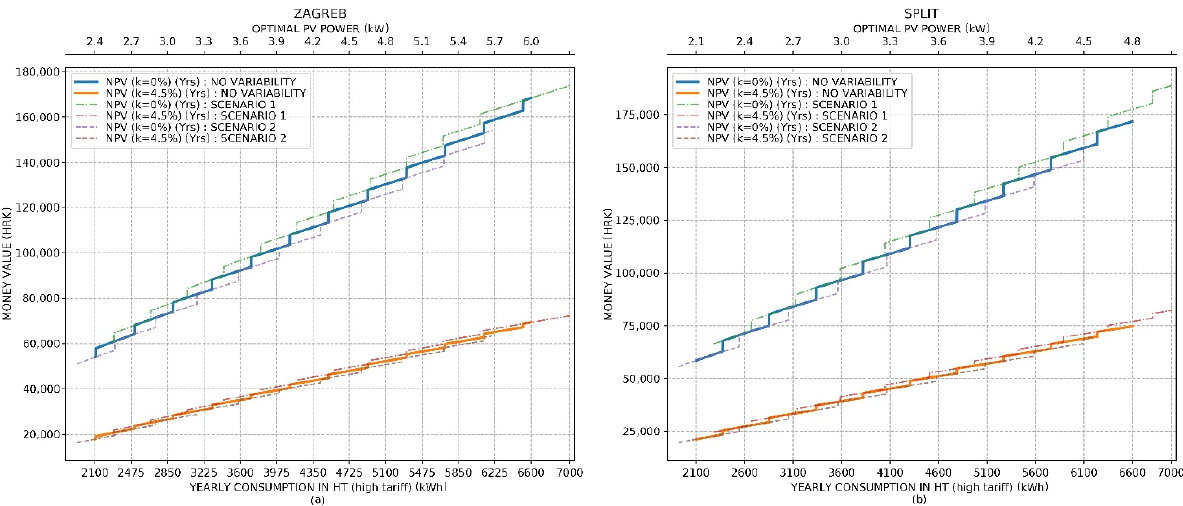
Figure 12. Simulation results of the net present value (NPV) for a PV system project with discount rates of 0% and 4.5%. ( a ) Simulation results for Zagreb. ( b ) Simulation results for Split.